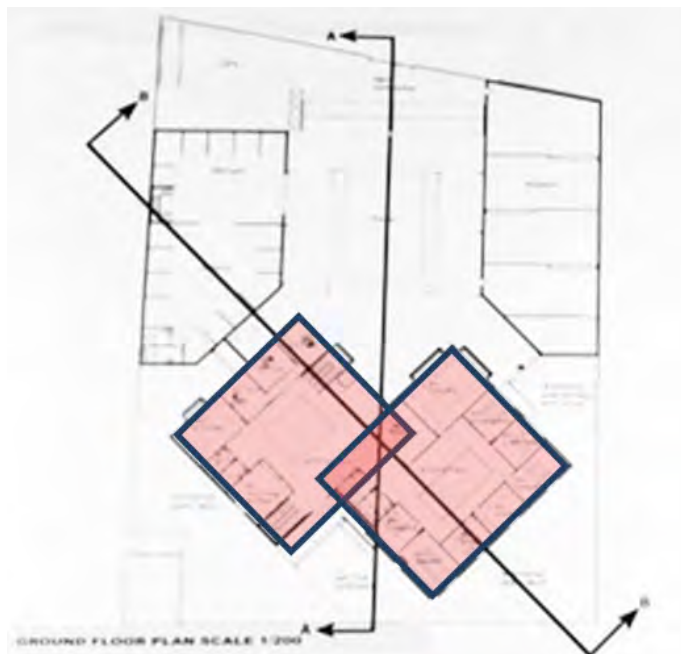
Figure 12. Showing the rotated masses occupied by women (“Salma Omar’s” Project)